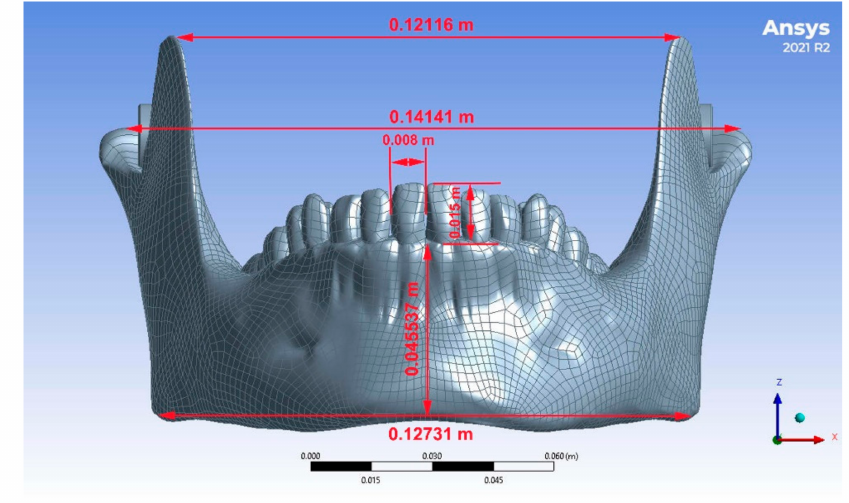
Figure 1. Characteristic dimensions of the mandible with teeth (m =